Question: Which visualization type does this figure use?
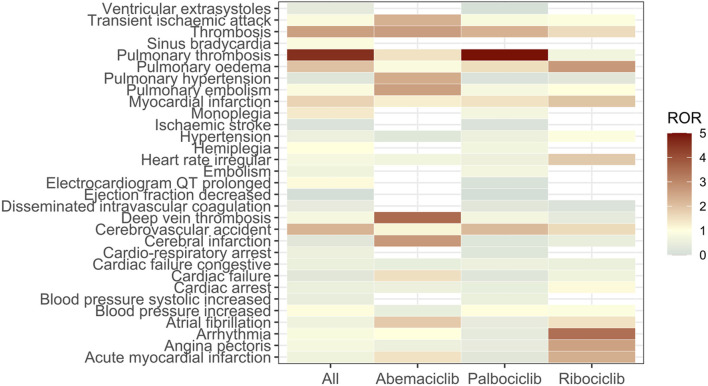
Answer: heatmap